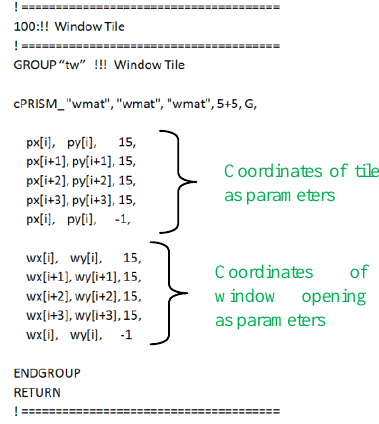
Figure 11. GDL code for vocabulary shape TW